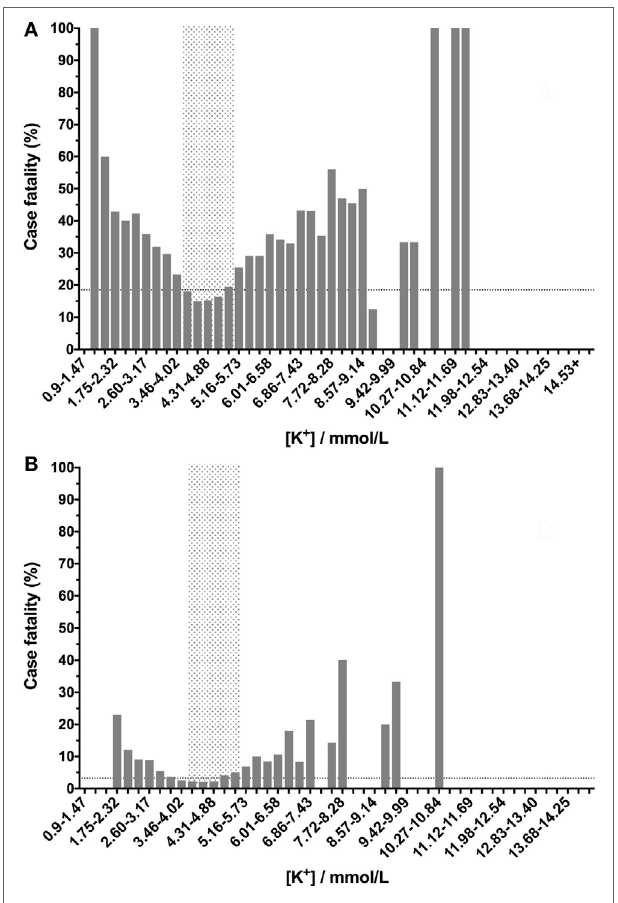
FigUre 3 | Canine blood potassium concentrations have a U-shaped relationship with case fatality rates. Low- or high-potassium concentrations are associated with increased case fatality rates. Blood potassium values were banded into 0.57 mmol/L bins, and the percentage case fatality for the patients in each of these subgroups was calculated. The dotted lines denote the case fatality rate across the entire data set (the background case fatality rate). Panel (a) represents data from all samples ( n = 33,117), including those from patients that were euthanized, while panel (b) represents data from patients that survived or died only (i.e., euthanized patients were excluded) ( n =